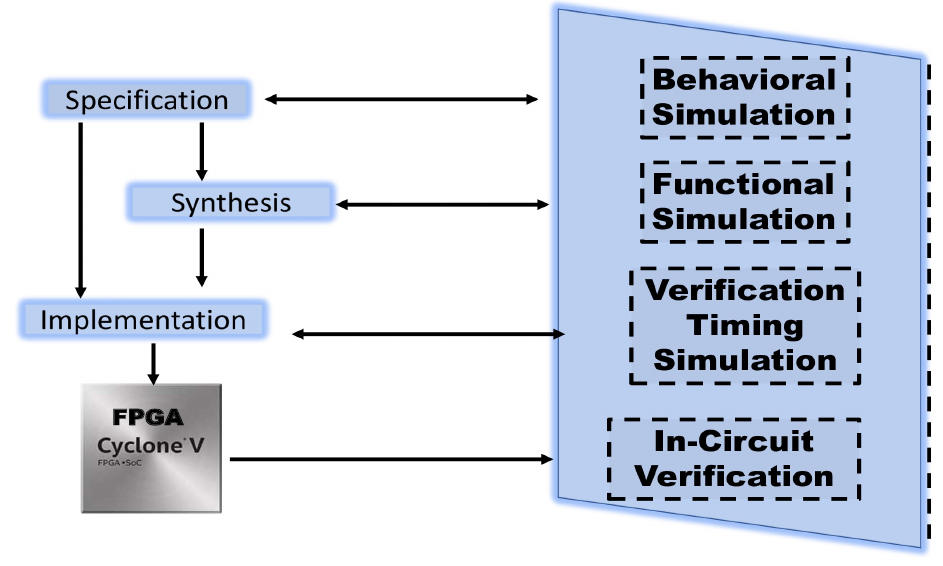
Figure 4. Typical FPGA design